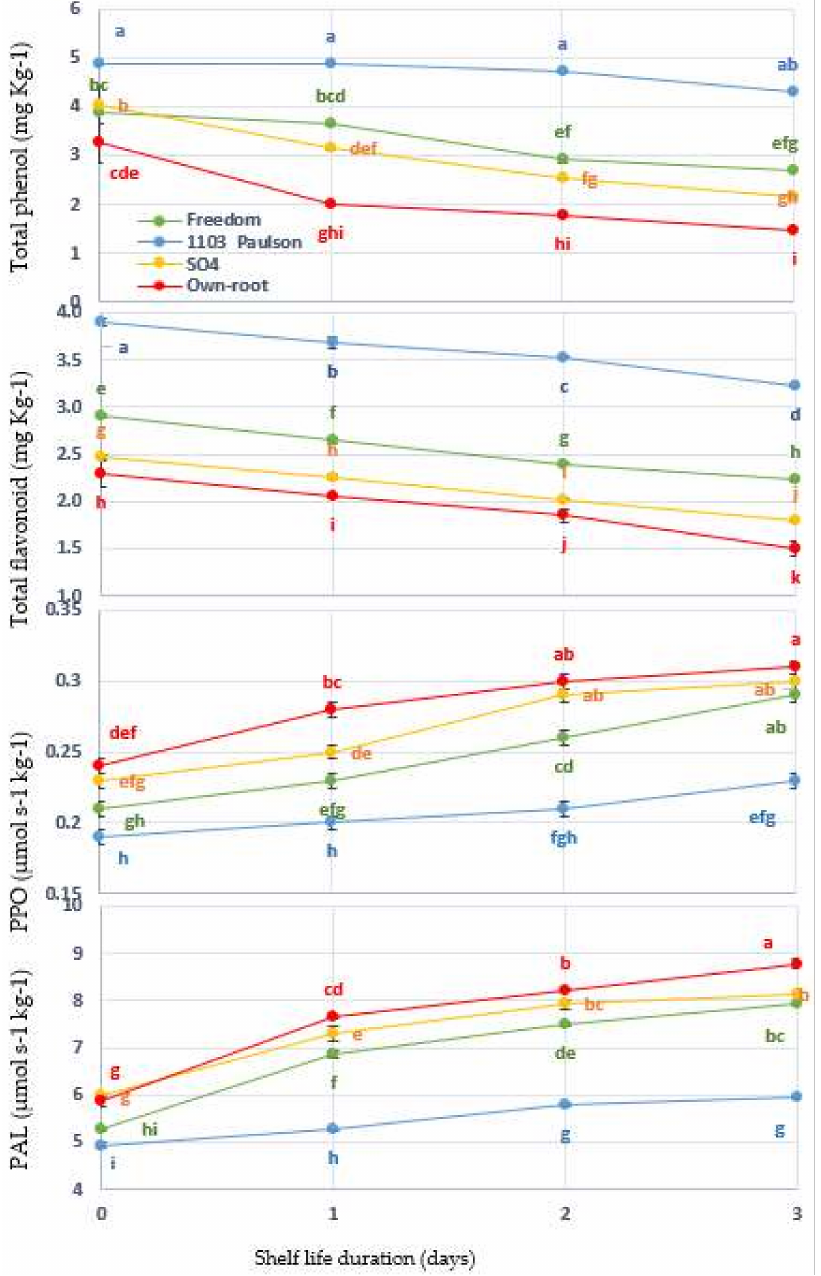
Figure 5. Interaction between Superior Seedless grapevine rootstocks (Freedom, 1103 Paulsen, SO4, and Own Root) and shelf life in days and effect on total phenol, flavonoid, poly phenol oxidase (PPO), and phenylalanine ammonia-lyase (PAL) during three days of shelf life (27 ± 1 ◦ C with 57 ± 3% RH). Significantly different samples, according to Tukey’s HSD test at 5%, are indicated by different